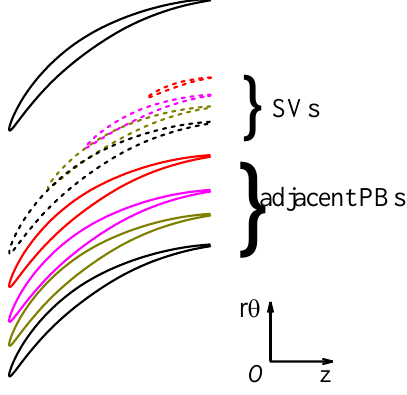
Figure 4. Systematic variation of CR with constant ES.